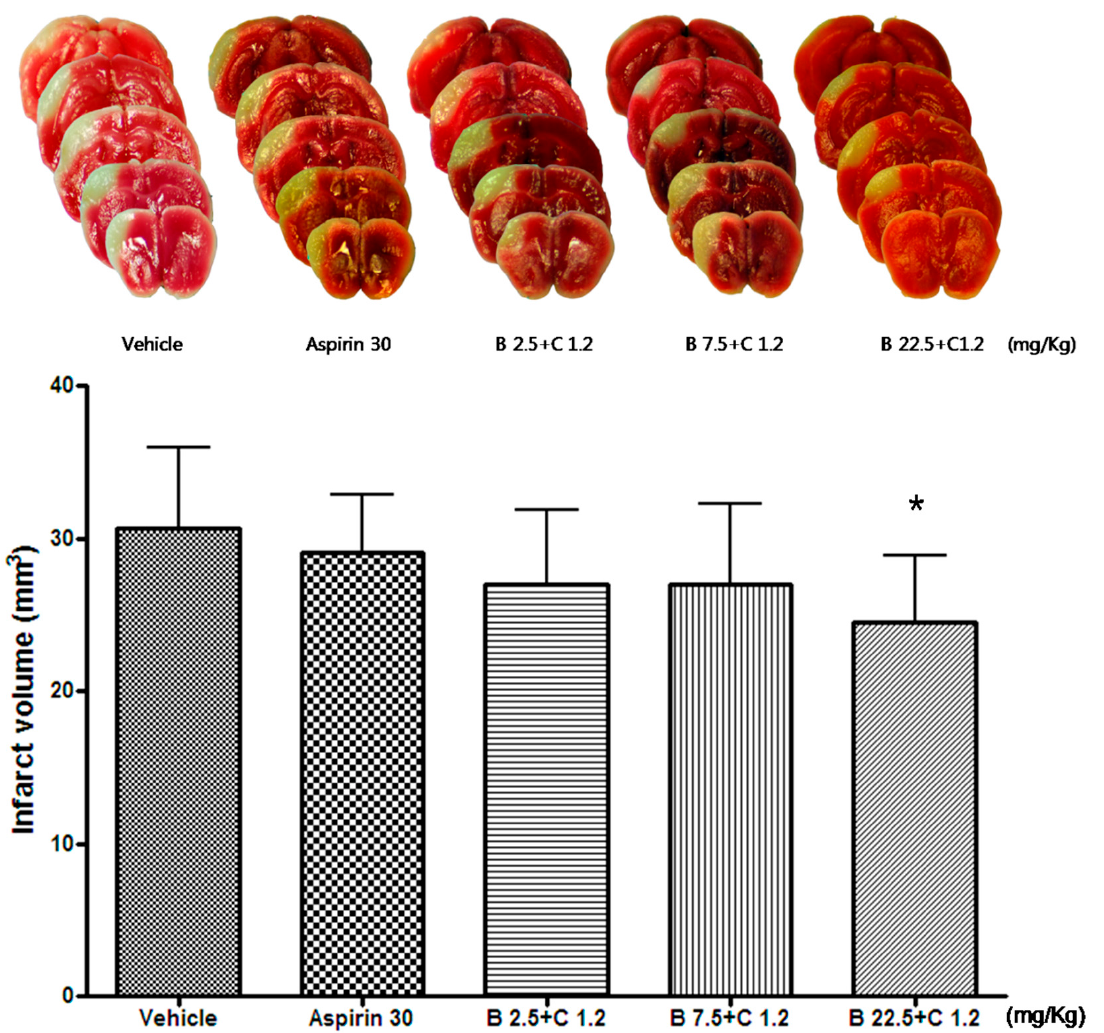
Figure 8. Effects of Sample A on ischemic brain injury after permanent middle cerebral artery oc- clusion (pMCAO). Infarct volume was measured 24 h after pMCAO. ( Upper ) Representative pho- tographs of infarcted brain slices from vehicle- and Sample A-treated mice. ( Lower ) There was no significant among-group difference in the cortical infarct volume after 24 h ( n = 8–10 mice for each group). Data represent means ± standard deviation. A, Chunghyuldan.